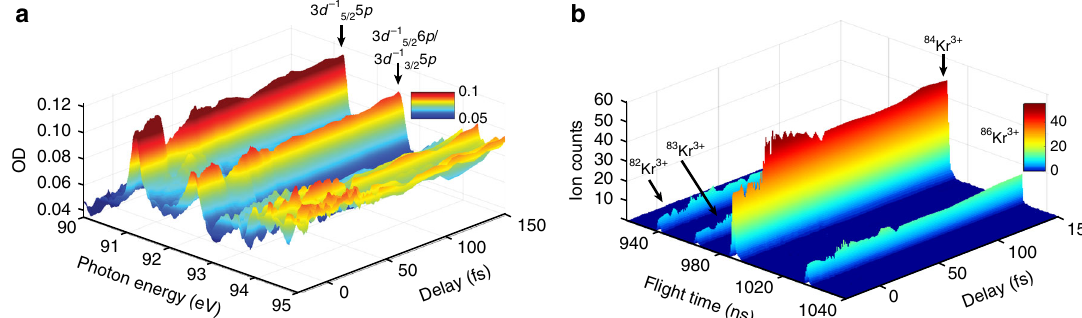
Fig. 2 Absorption and ionization spectroscopy measurements. a Spectrally resolved optical density OD with respect to the time delay between the XUV and the NIR pulse, revealing the 3 d − 1 5/2 5 p and 3 d − 1 5/2 6 p /3 d − 1 3/2 5 p resonances at 91.23 eV and 92.45 eV, respectively. The XUV pulse is preceding the NIR pulse for positive times on the delay axis. The absorbance at the resonances transiently decreases at XUV/NIR pulse overlap and subsequently recovers almost to its original value, with an exponential time constant corresponding to the state lifetimes. b Time-dependent and isotope-resolved Kr 3+ ion yield. For all isotopes similarly, the Kr 3+ ion yield rises shortly before XUV/NIR pulse overlap and decays with a slower time constant when compared to the transient absorption in the left panel to a persistent elevated count rate. In both cases, the NIR intensity was (8.6 ± 1) × 10 13 W cm − 2